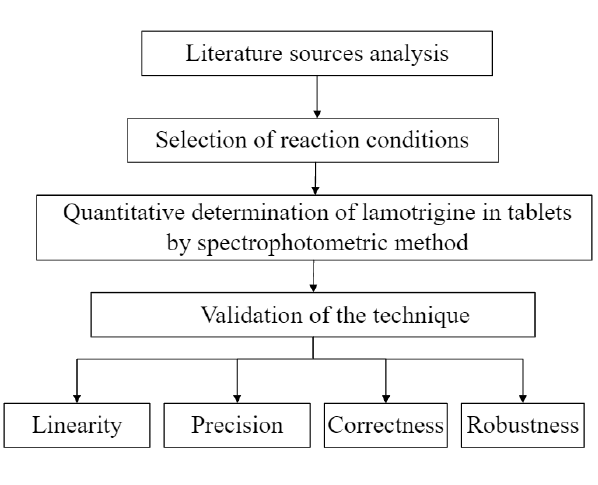
Fig. 1. Planning of the